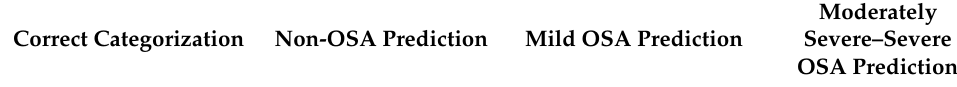
Table 15. Summary table of accuracy of categorisations based on different sets of information. OSA: obstructive sleep apnoea; BMI: body mass